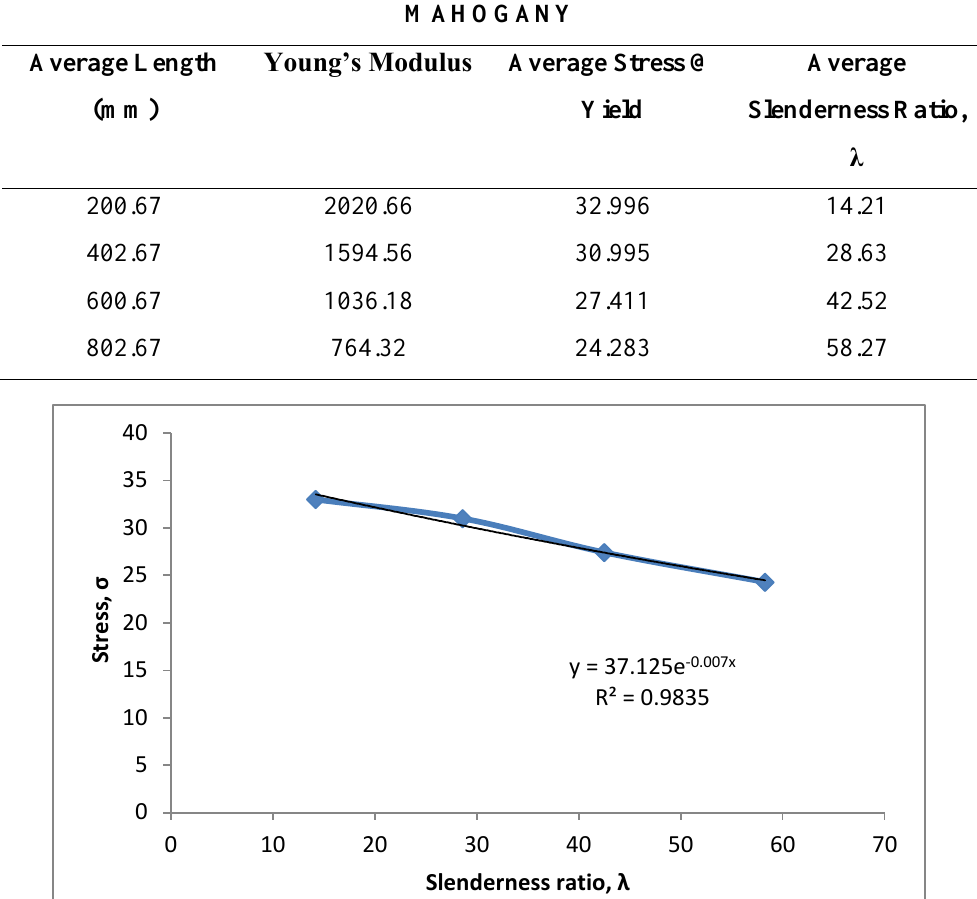
Fig. 5. Average Stress @ Yield vs Slenderness Ratio Curve for Iroko. Young’s Modulus, Stress@Yield, Slenderness Ratio relationship.